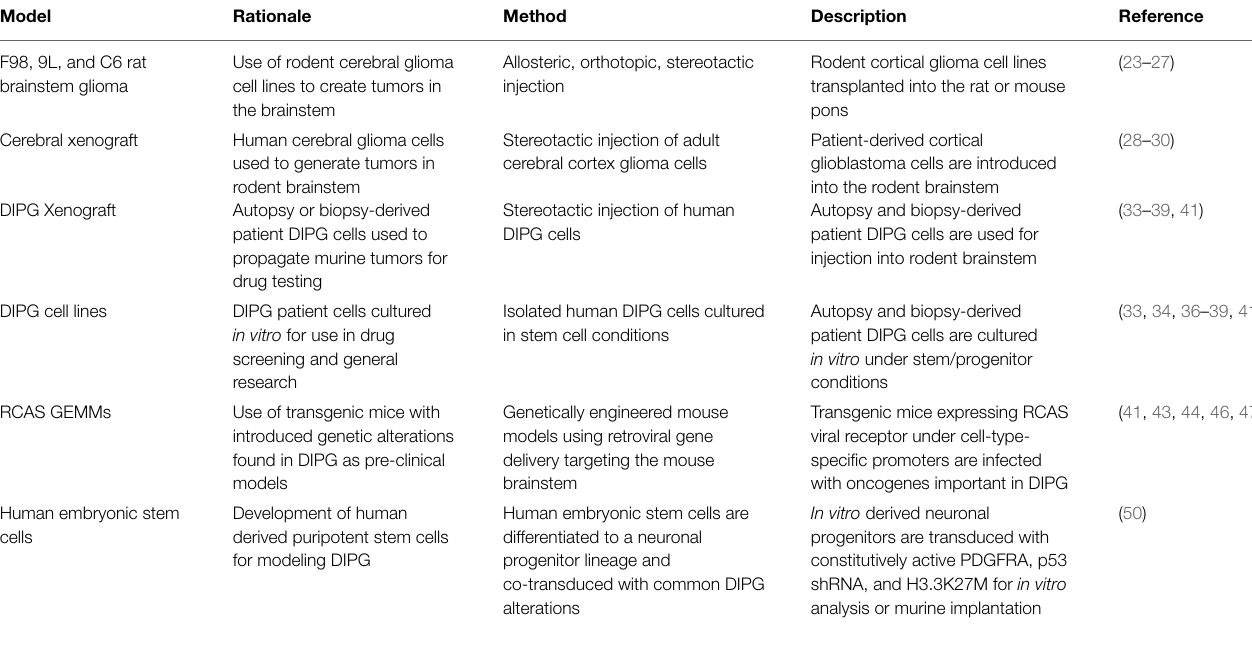
TABLE 1 | Animal models of DIPG